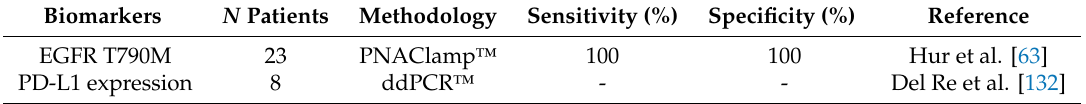
Table 3. Principal clinical biomarkers detectable by extracellular vesicles (EVs). Biomarkers N Patients Methodology Sensitivity (%) PD-L1